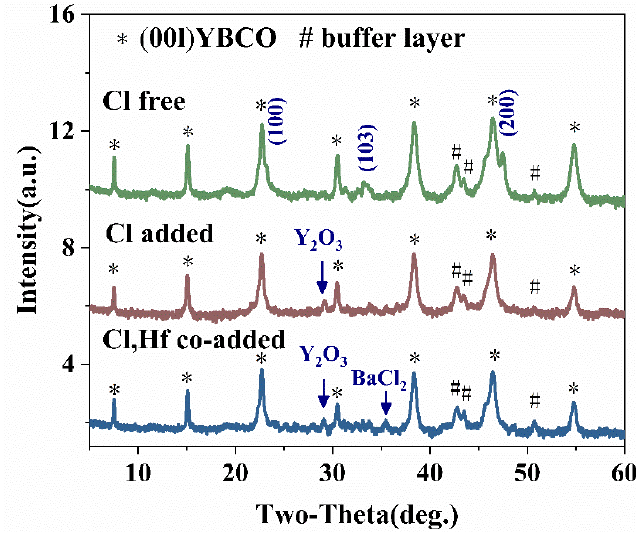
Figure 1. The surface XRD patterns of Cl-free, Cl-added and (Cl, Hf) co-added YBCO films.